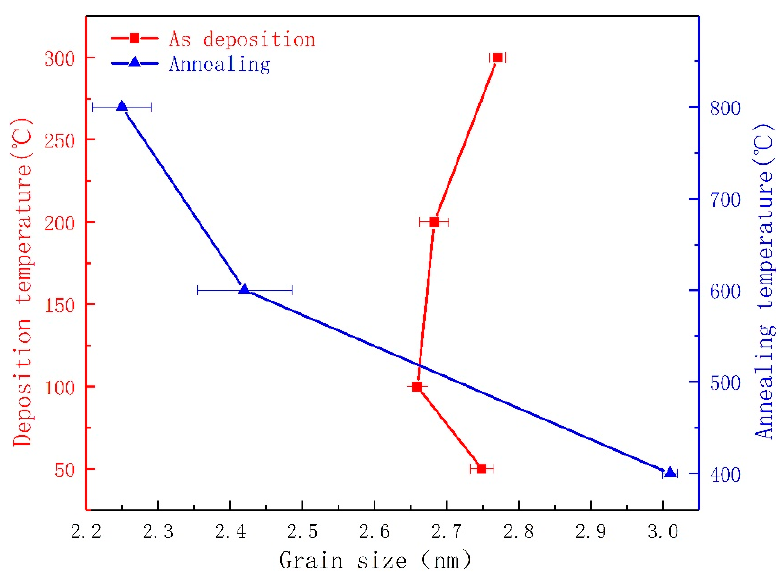
Figure 6. Relationship between the grain size of the MoS 2 films and the deposition and annealing temperatures.